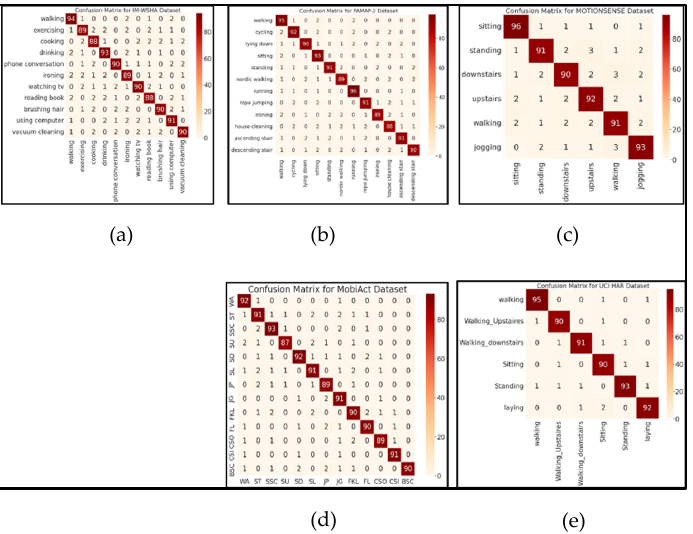
Figure 10. Confusion matrices of ( a ) the 11 daily living activities on the IM-WSHA dataset via random forest, ( b ) 12 physical activities on the PAMAP-2 dataset via random forest, ( c ) 6 locomotion activities on the MOTIONSENSE dataset via random forest, ( d ) 6 locomotion activities on the UCI HAR dataset via random forest, ( e ) 6 locomotion activities on the MobiAct dataset via random forest. WA = walking, ST = standing, SSC = stand to sit on chair, SU = stairs up. SD = stairs down, SL = sideward ‐ laying, JP = jumping, JG = jogging, FKL= front ‐ knees ‐ laying, FL= forward ‐ laying, CSO = car ‐ step ‐ out, CSI = car ‐ step in, BSC = back ‐ sitting ‐ chair.